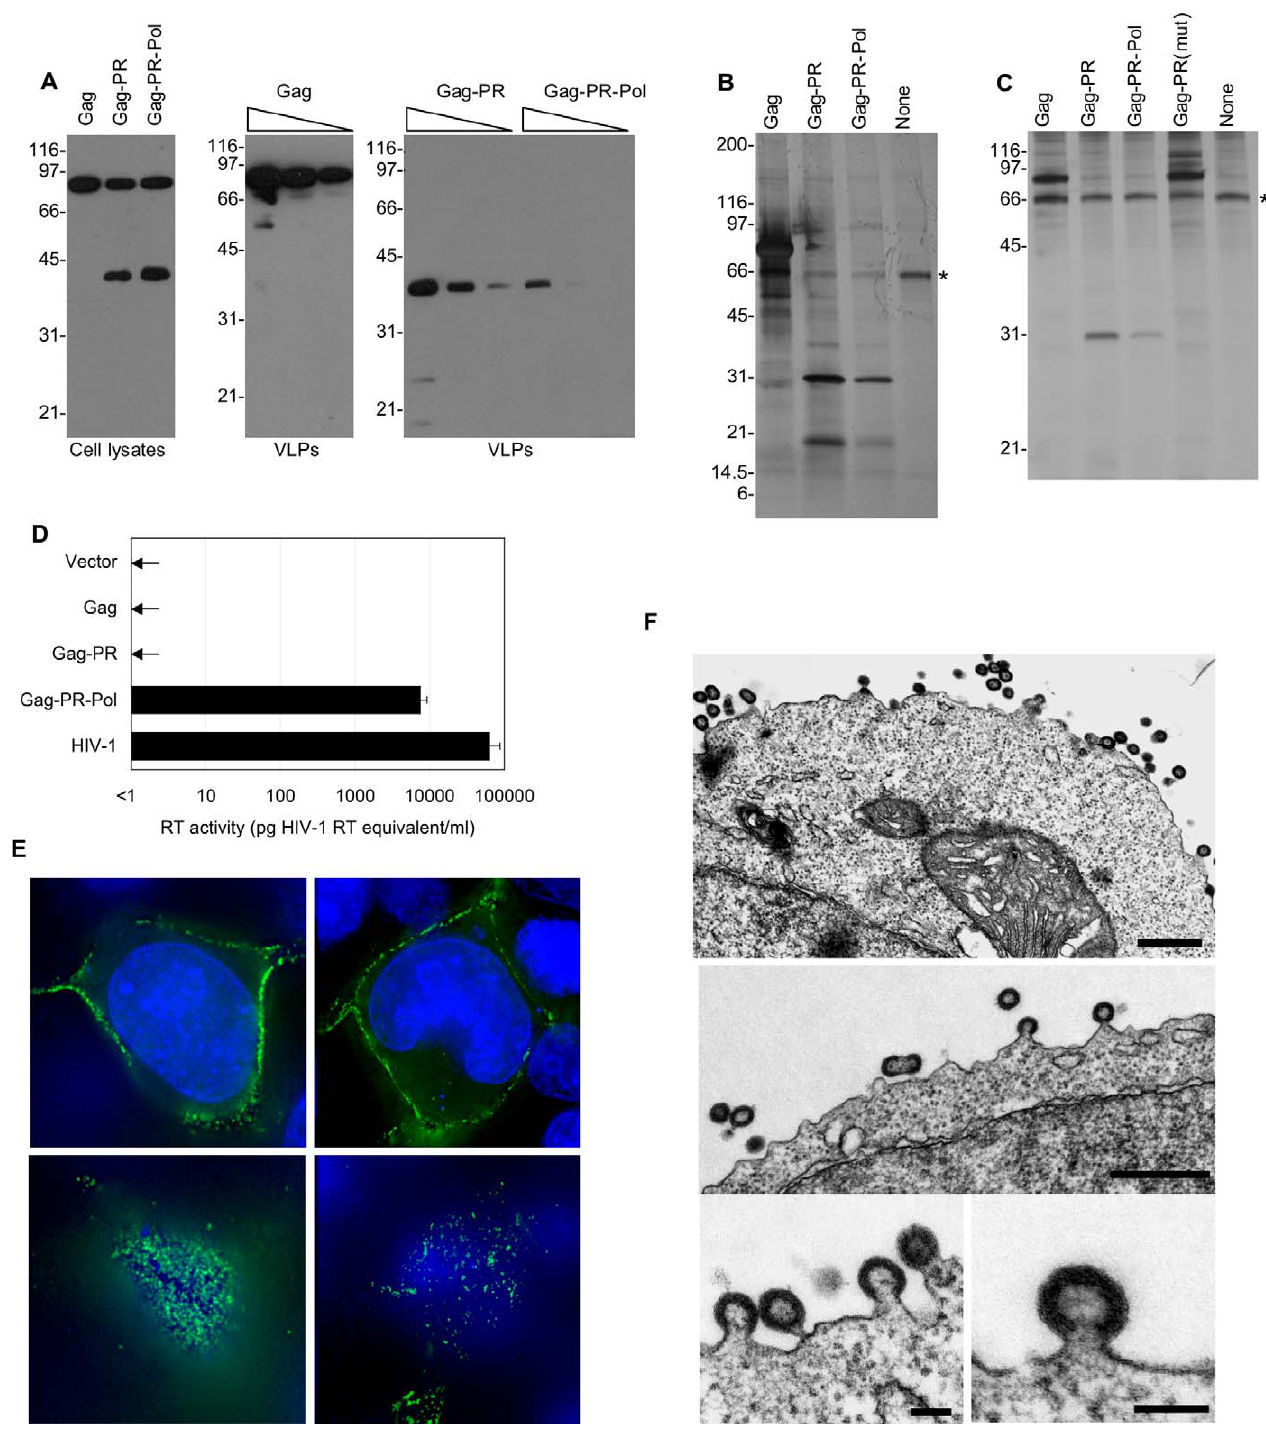
Figure 2. Assembly, Processing, and Release of HERV-K Virus-Like Particles (A–D) 293T cells were transfected with Gag-, Gag-PR–, or Gag-PR-Pol–expressing vectors. (A) Western blot analysis of cell lysates (left) and virions (center and right) using a commercially available antibody to HERV-K Gag. Center shows VLPs from 293T cells transfected with a plasmid-expressing Gag, and right shows VLPs from Gag-PR– and Gag-PR-Pol–expressing 293T cells. Decreasing amounts of virion lysate (0.1, 0.05, or 0.025 l l for Gag; 0.4, 0.2, or 0.1 l l for Gag-PR and Gag-PR-Pol) were loaded to semiquantitatively estimate relative levels of VLP production. (B) Silver stain analysis of a 4% to 20% gradient SDS-PAGE gel loaded with VLPs harvested from 293T cells transfected with plasmids expressing Gag, Gag-PR, Gag-PR-Pol, or empty plasmid control. An asterisk marks a nonspecific 66-kDa protein band, most probably BSA, that is abundant in the culture medium. (C) Silver stain analysis of VLPs harvested from 293T cells containing Gag, Gag-PR, Gag-PR-Pol, or Gag-PR(mut) encoding an active site mutation (DTG- AAA) in protease. An asterisk marks a nonspecific 66-kDa protein band, most probably BSA, that is abundant in the culture medium. (D) Reverse transcriptase activity in culture supernatants of 293T cells transfected with empty pCRV1 (vector) or vectors expressing HERV-K CON Gag, PLoS Pathogens |